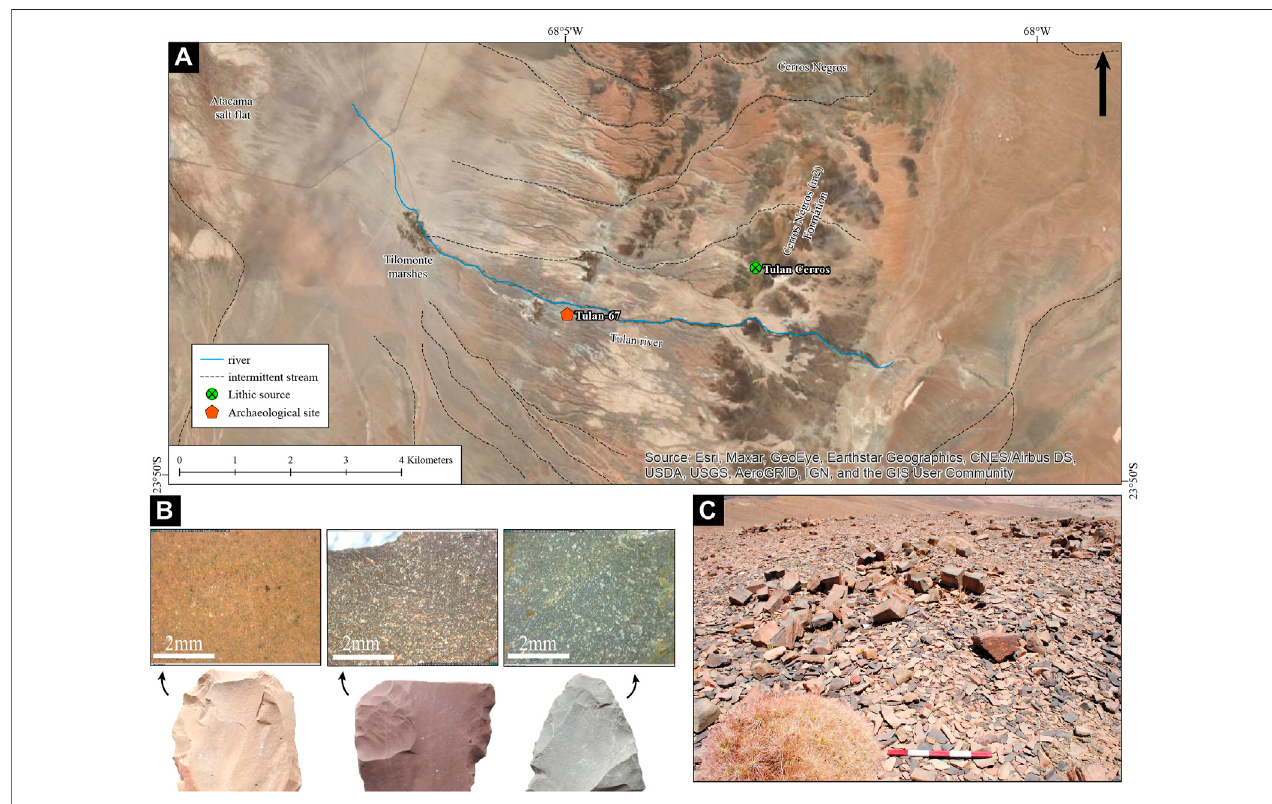
FIGURE 9 | Tulán Cerros source complex: (A) geological context; (B) raw material samples; (C) Tulán Cerros-2 quarry-workshop site.